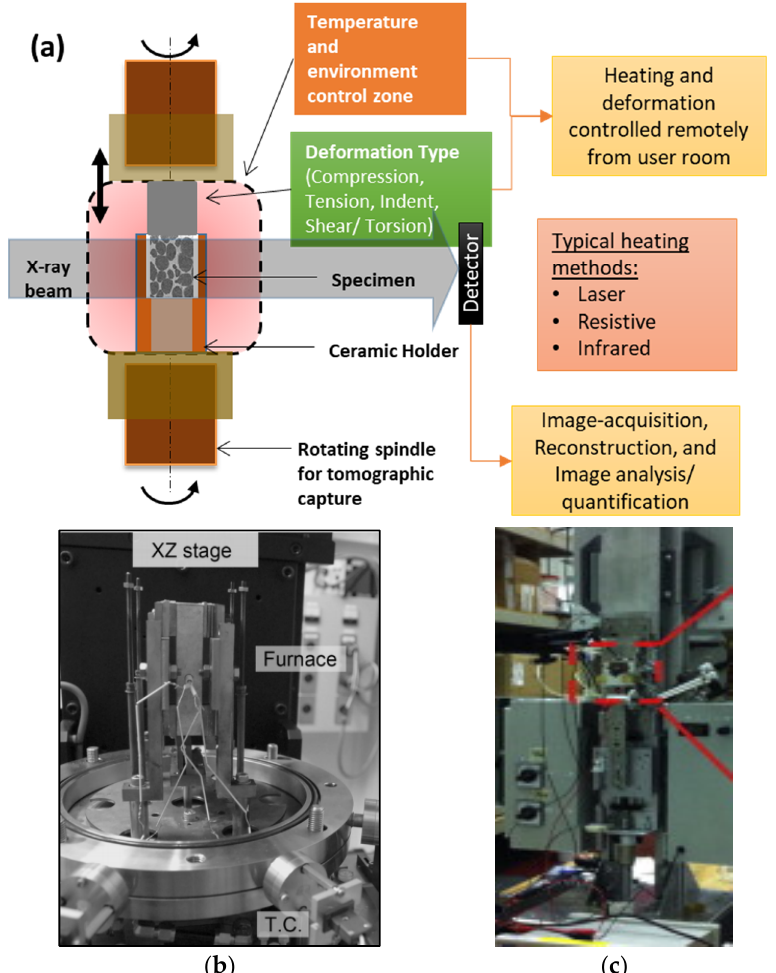
Figure 2. Examples of in situ experimental set-up for X-ray imaging: ( a ) schematic of a typical thermal-mechanical stage for tomographic imaging, ( b , c ) Photographs of experimental set-ups